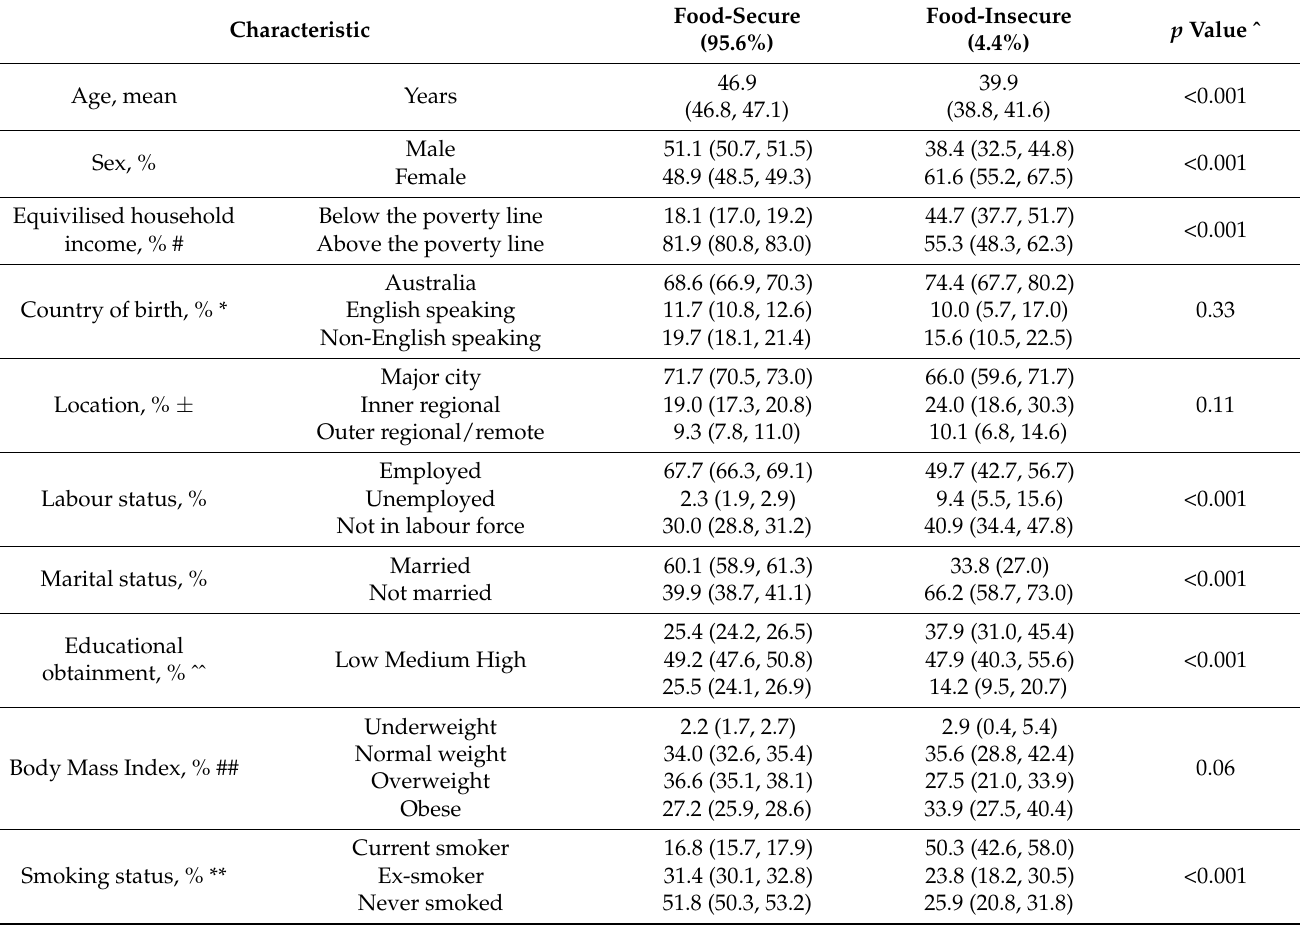
Table 1. Survey-weighted socio-demographic and health characteristics of Australian adults by food security status using the NNPAS